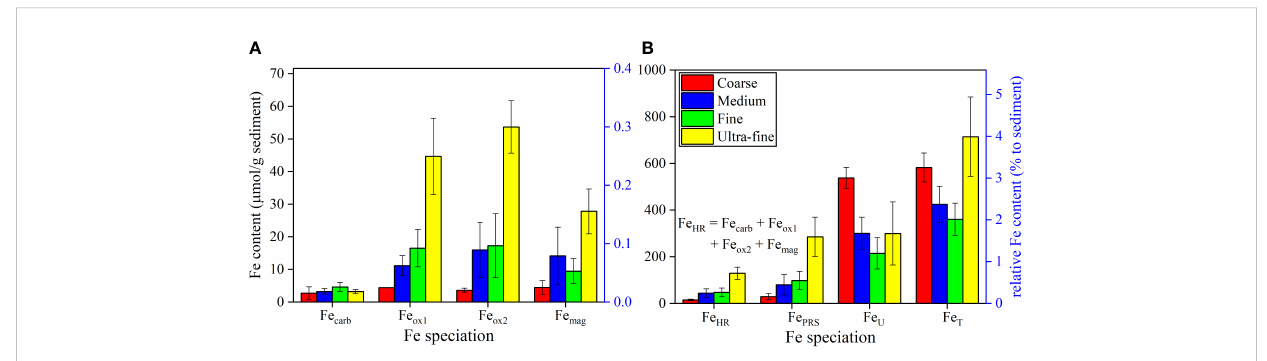
FIGURE 3 The average content of (A) Fe carb , Fe ox1 , Fe ox2 , Fe mag and (B) Fe HR , Fe PRS , Fe U , Fe T in “ Coarse ” , “ Medium ” , “ Fine ” and “ Ultra- fi ne ” categories of sediments from Prydz Bay and the adjacent Southern Ocean. Note: Fe HR = Fe carb + Fe ox1 + Fe ox2 + Fe mag .